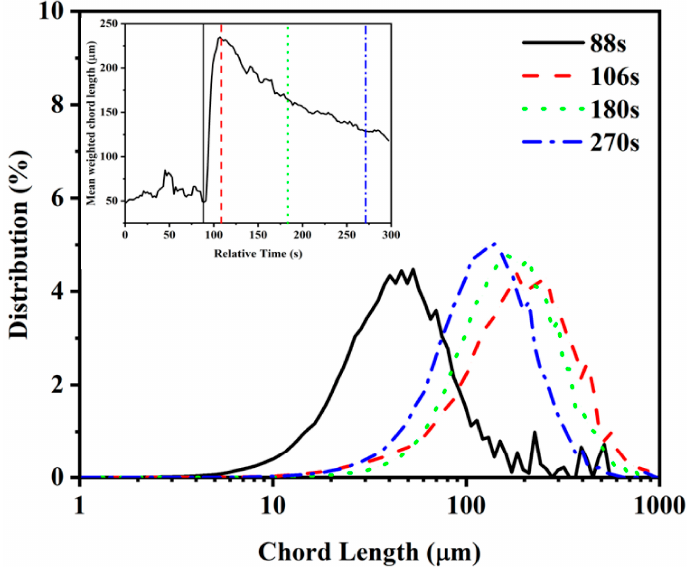
Figure 8. The trend of Mean Particle Size and PSD (square weighted, macro mode) as a function of stirring time: 100 g/t PEO, 400 rpm. stirring time: 100 g/t PEO, 400